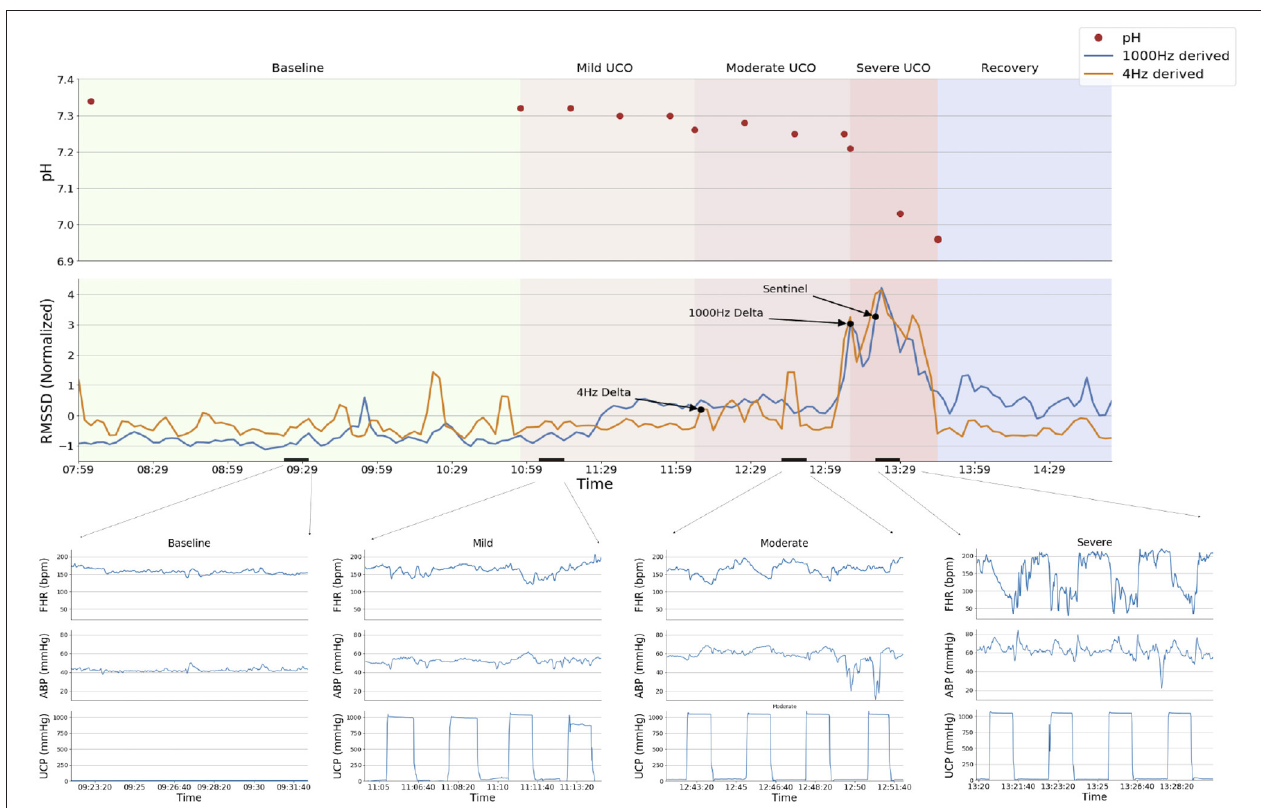
FIGURE 1 | Experimental protocol and a representative example of the analytical approach (animal ID 473378). The RMSSD time series derived from 1,000Hz (blue) and 4Hz (orange) sampled ECG are displayed superimposed in the top panel, with declared change points from the BOCPD algorithm and the Sentinel (expert detection) marked with arrows. Sequential fetal arterial pH measurements are indicated. Experimental stages are demarcated by background colors; short black bars over X-axis indicate the zoomed-in segments shown in the bottom panel. Bottom panels show fetal heart rate (FHR, bpm), fetal arterial blood pressure (ABP, mmHg) and umbilical cord pressure (UCP, mmHg) indicating when UCO were triggered (increasing UCP). Note the failure of the change point algorithm to detect the sentinel time point correctly (i.e., around the Sentinel time point) when using 4 Hz—derived RMSSD signal: the detection occurs 1h earlier than with the 1,000Hz signal. This is due to unphysiological fluctuations in FHR variability at baseline as demonstrated in Durosier et al. (7) and Li et al.